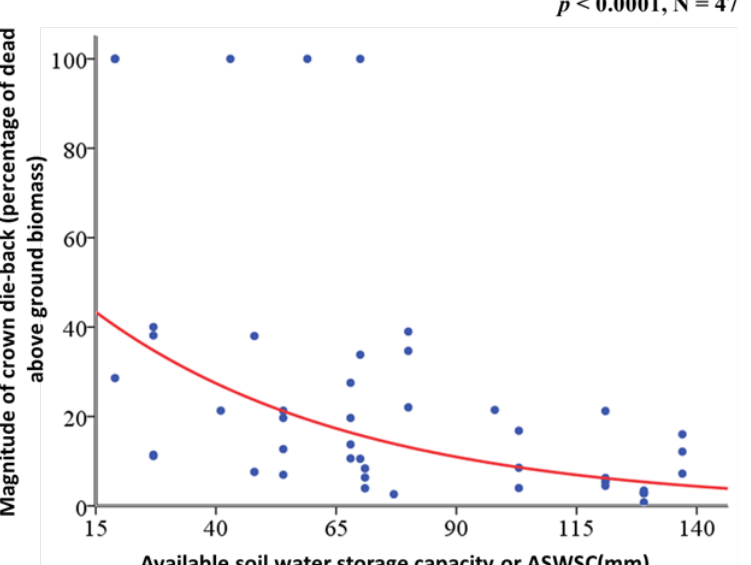
Figure 1. Relation between crown dieback, expressed by dead above ground biomass percentage and soil water stress calculated by the available soil water storage capacity (ASWSC in